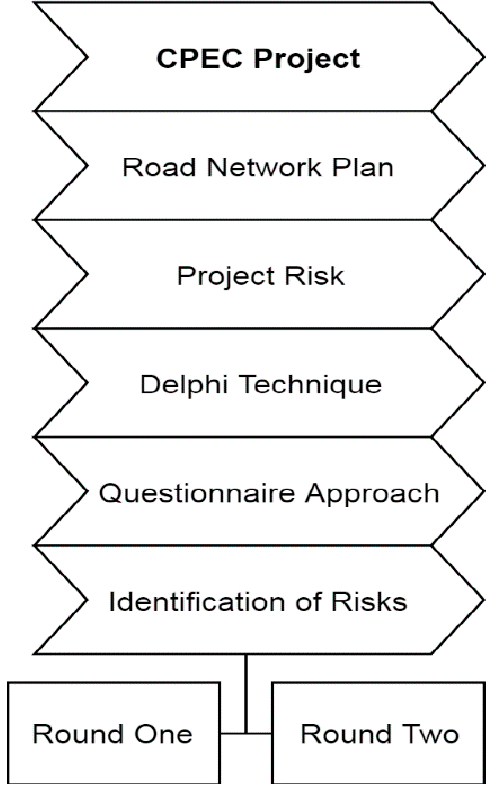
Figure 2. Framework of the present study.